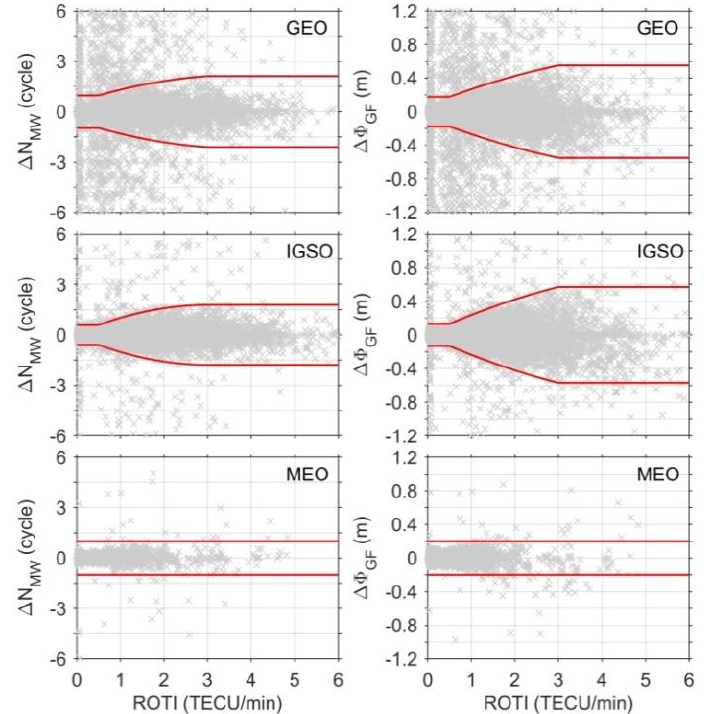
Figure 6. Distribution of ∆ N MW and ∆Φ GF against the scintillation index ROTI based on one-year BDS dataset from HKST. The red lines represent the cycle-slip thresholds relative to different ROTI values.